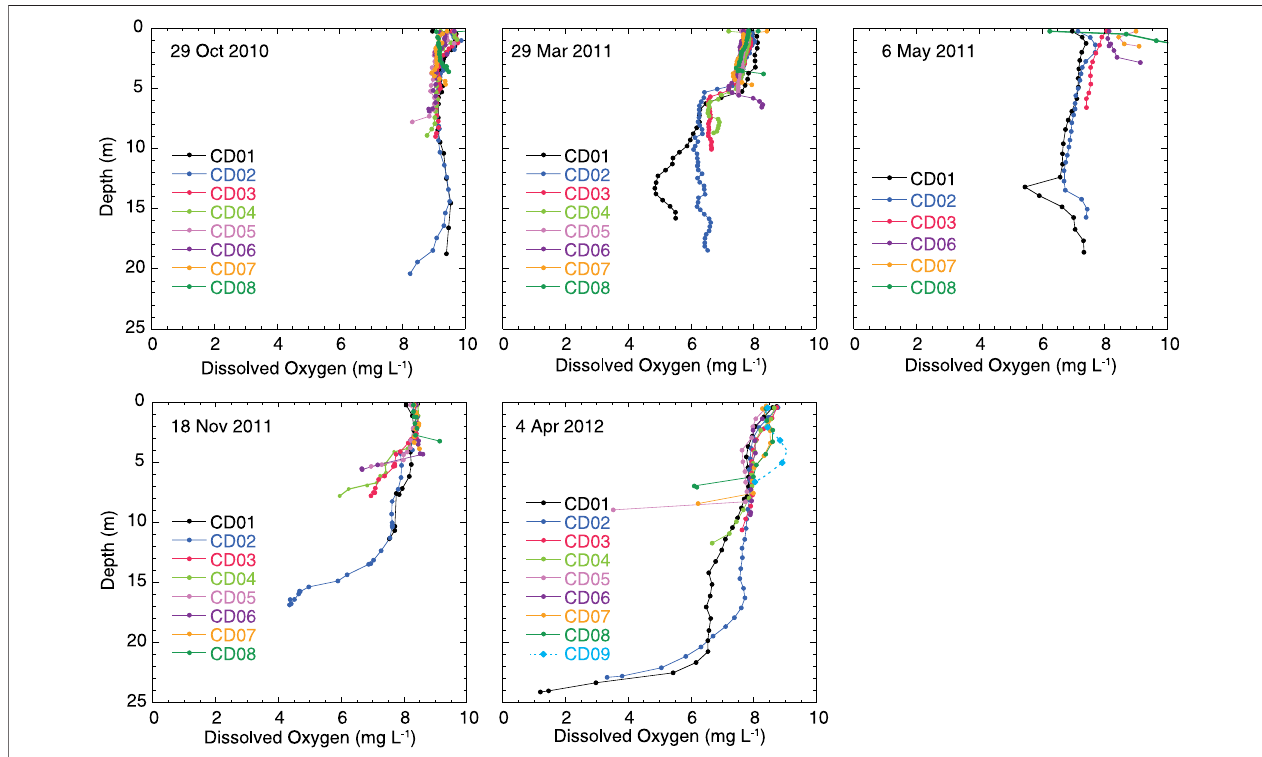
FIGURE 8 | Water column dissolved oxygen pro fi les at each site during the fi ve fi eld trips: 29 October 2010. 29 March 2011, 6 May 2011, 18 November 2011, 4 April 2012.